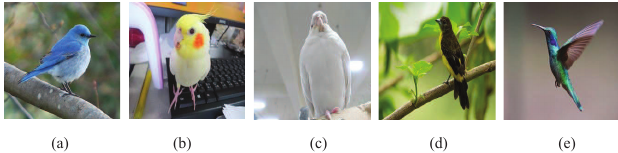
Figure 8. Five color cover images with photos of birds: ( a ) CCI 1 ( b ) CCI 2 ( c ) CCI 3 ( d ) CCI 4 ( e ) CCI 5